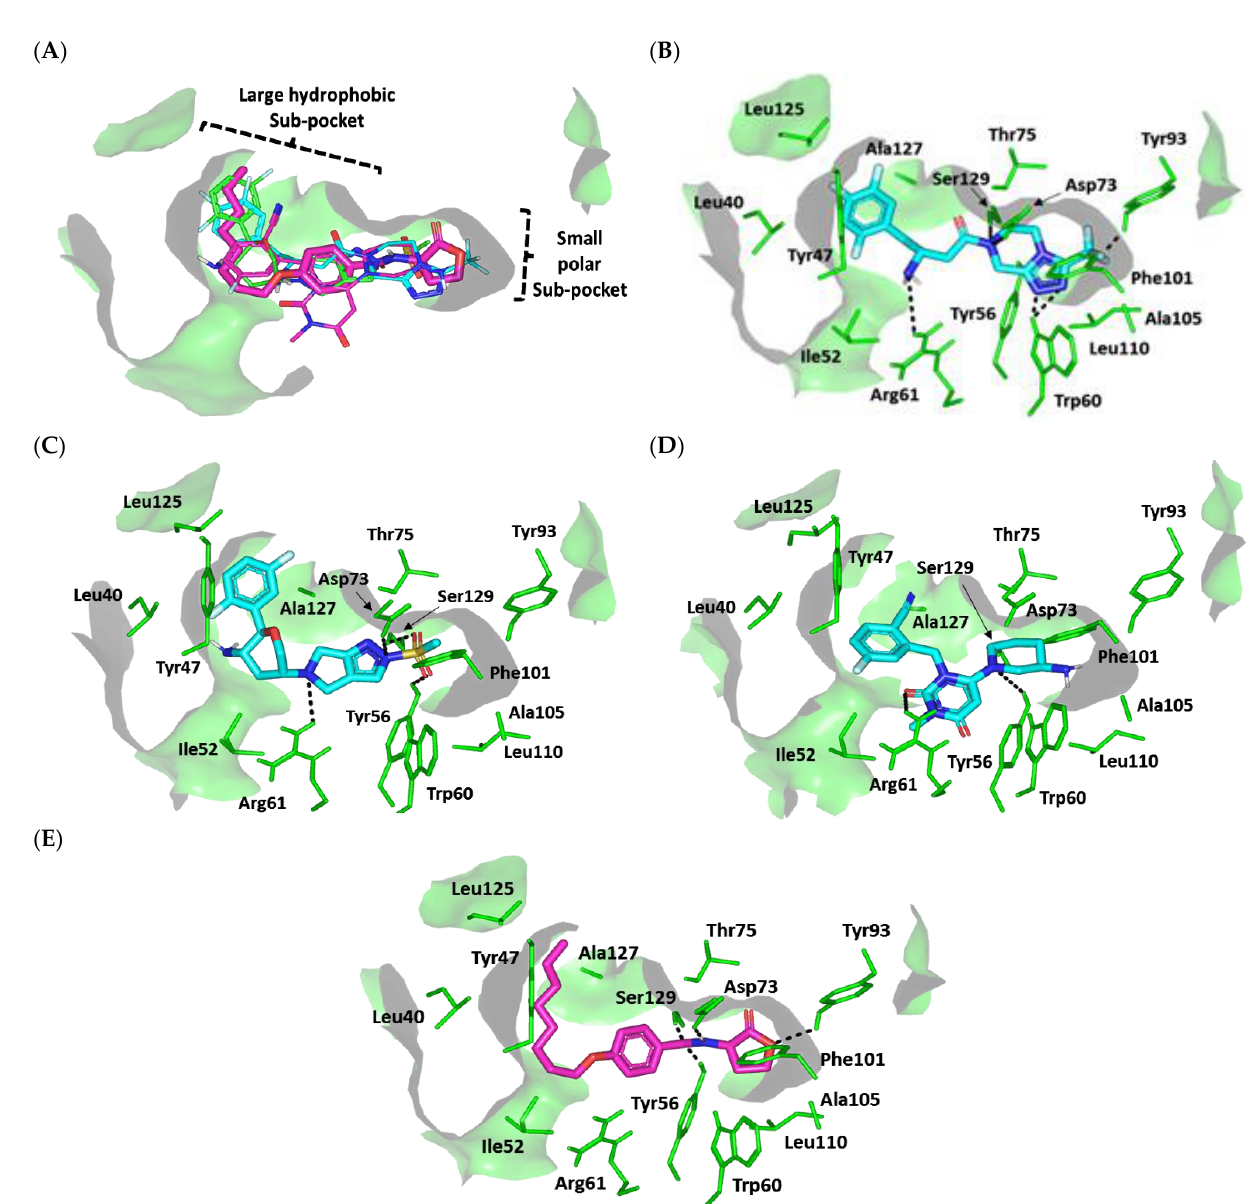
Figure 9. Ligand – protein binding interactions at P. aeruginosa LasR quorum-sensing transcription protein binding site. ( A ) Overlay of investigated compounds (SIT, OMR, and TRG as cyan, green, and purple lines, respectively) and Q9 (magenta sticks) binding to the protein’s canonical binding site comprising small polar head and larger hydrophobic subpockets. ( B – E ) Predicted binding modes of the docked ligands (cyan or magenta sticks): ( B ) SIT, ( C ) OMR; ( D ) TRG, and ( E ) Q9. Only amino acids located within 5 Å radius distance from the bound ligand are displayed and labeled with sequence numbers. Non-polar hydrogen atoms are hidden for clarity. Hydrogen bonding is depicted as black dashed lines.